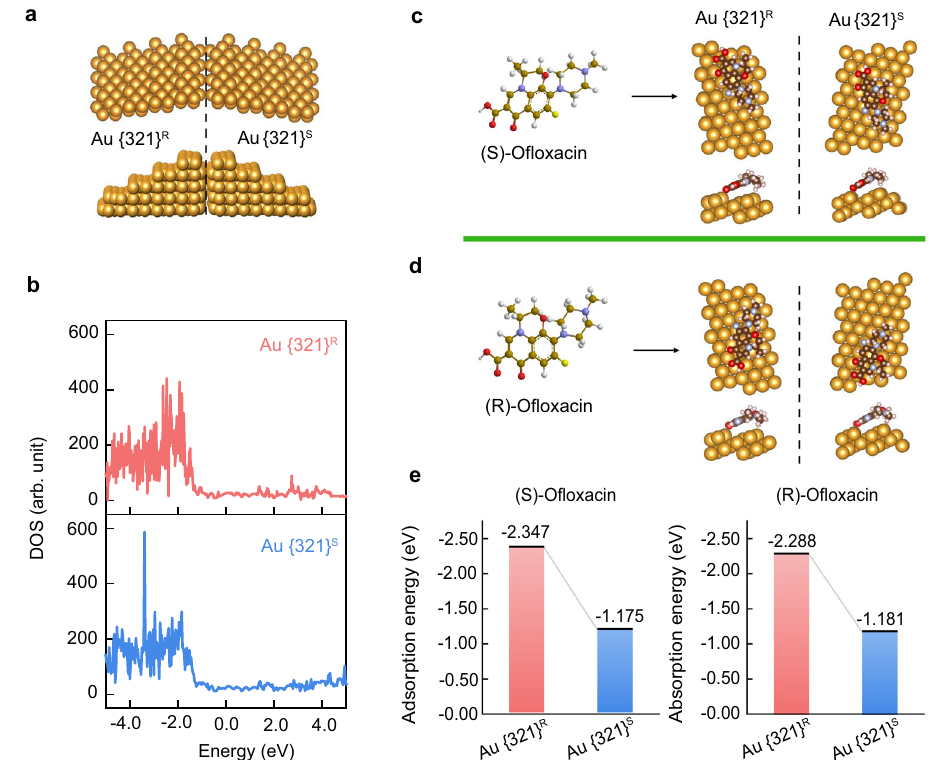
Fig. 4 | Simulation indicating different interactions between o fl oxacin enan- tiomers and chiral gold surfaces. a Comparison of the atomic arrangement of {321} R and {321} S gold surfaces. b Density of state (DOS) results show the variety of structures or chiralcrystalline faces. c , d Optimizedadsorption modules of (S)/(R)-